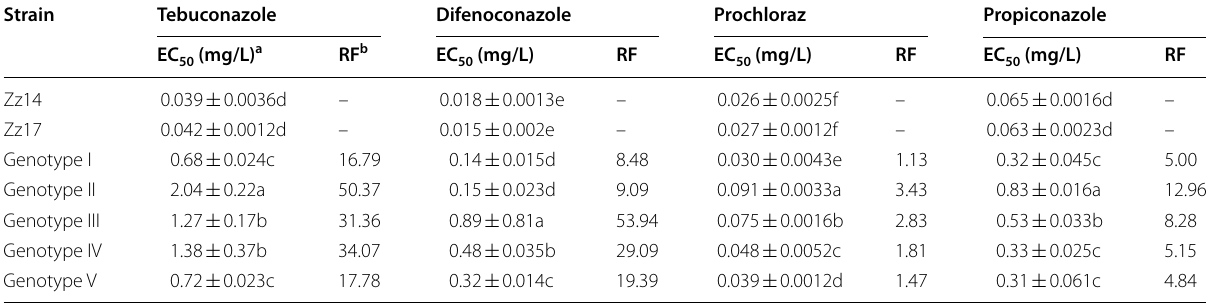
a Values are the means standard deviations from three replicate experiments. Different letters indicate significant differences according to the Fisher’s LSD test at ± P 0.05. b RF (resistance factor) EC 50 value (resistant isolate)/EC 50 value (sensitive = =